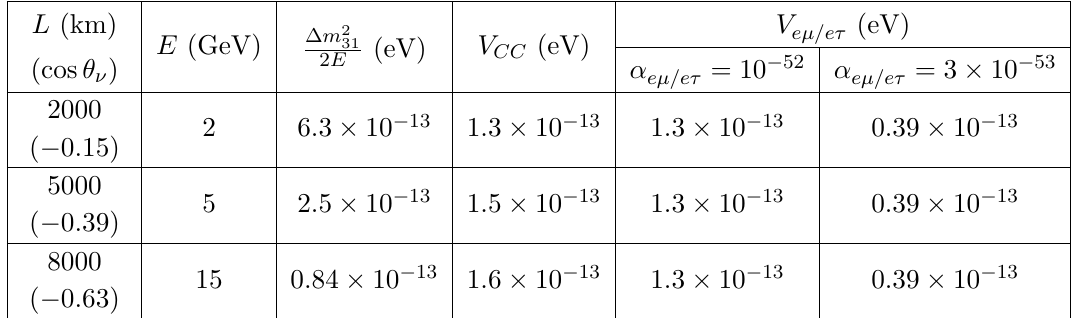
Table 1 . The values of (cid:1) m 2 = 2 E (third column), V CC (fourth column), and V ((cid:12)fth column) e(cid:22)=e(cid:28) 31 for our benchmark choices of E , L , and (cid:11) . We take (cid:1) m 2 = 2 : 524 (cid:2) 10 (cid:0) 3 eV 2 . Based on e(cid:22)=e(cid:28) 31 the PREM pro(cid:12)le, the line-averaged constant Earth matter densities for 2000 km, 5000 km, and 8000 km baselines are 3.46 g/cm 3 , 3.9 g/cm 3 , and 4.26 g/cm 3 respectively. The parameter (cid:18) (cid:23) is the zenith angle for a given